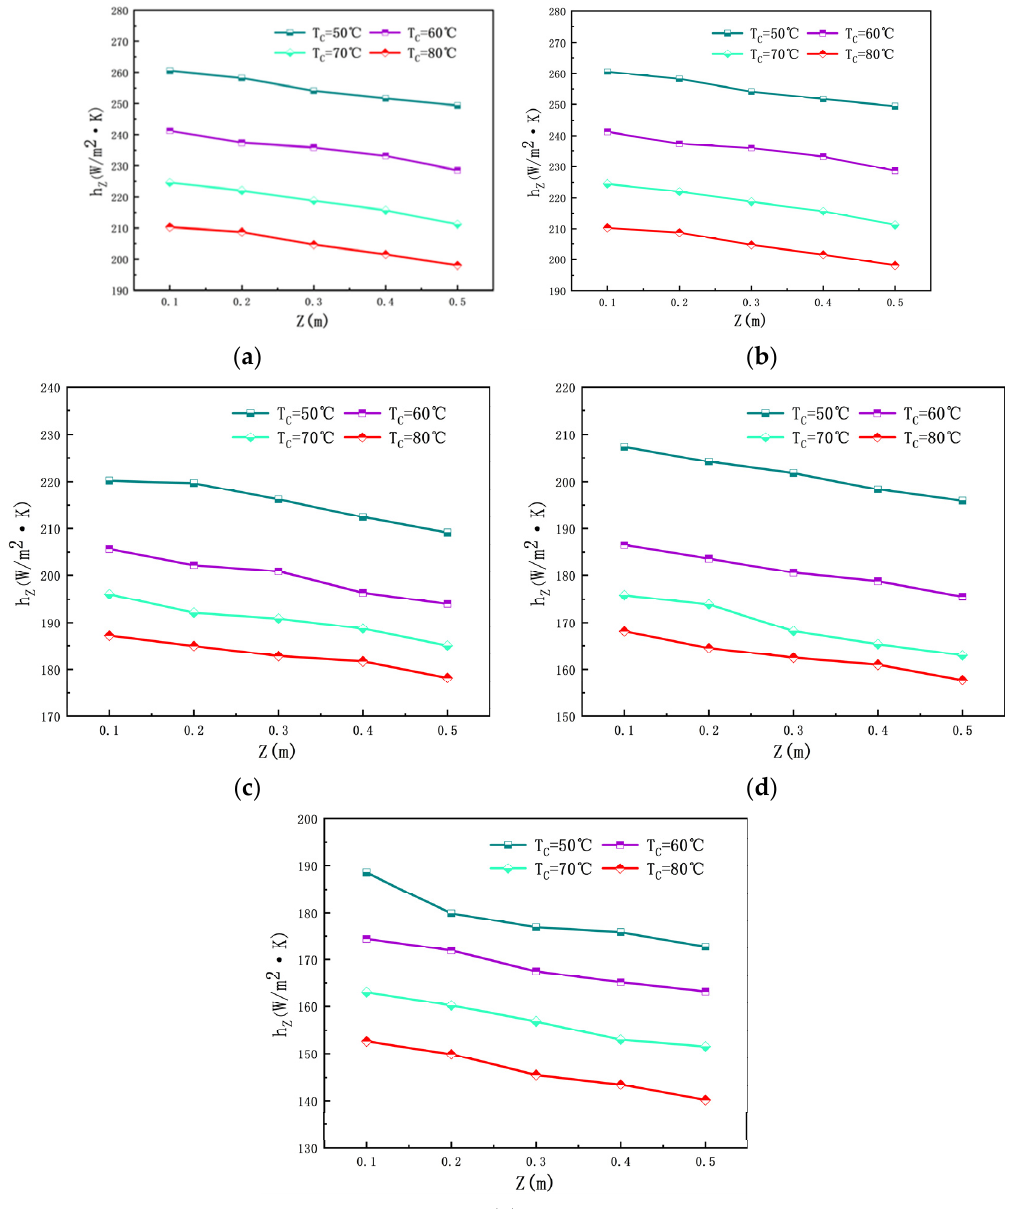
Figure 6. The relationship between the local convective heat transfer coefficient and height (Z) under different flow rate ratios. ( a ): m d /m c = 1:5. ( b ): m d /m c = 1:4. ( c ): m d /m c = 1:3. ( d ): m d /m c = 1:2, ( e ): m d /m c = 1:1.